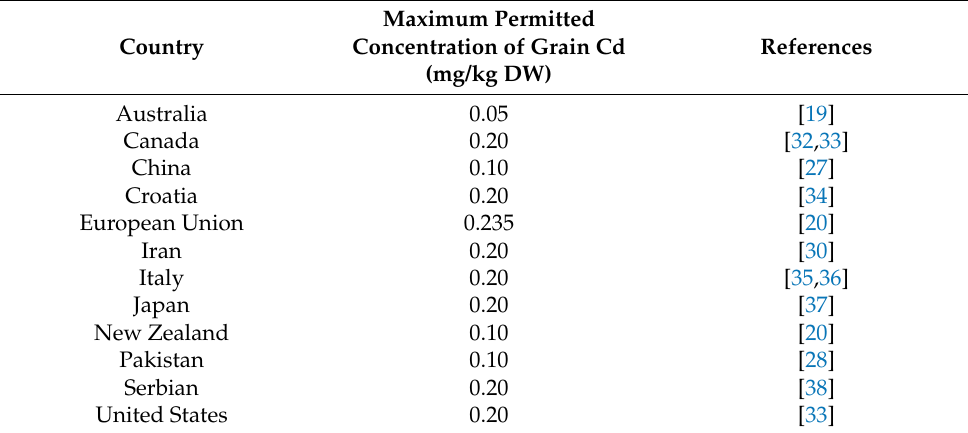
Table 2. Maximum permitted concentration of grain Cd in individual